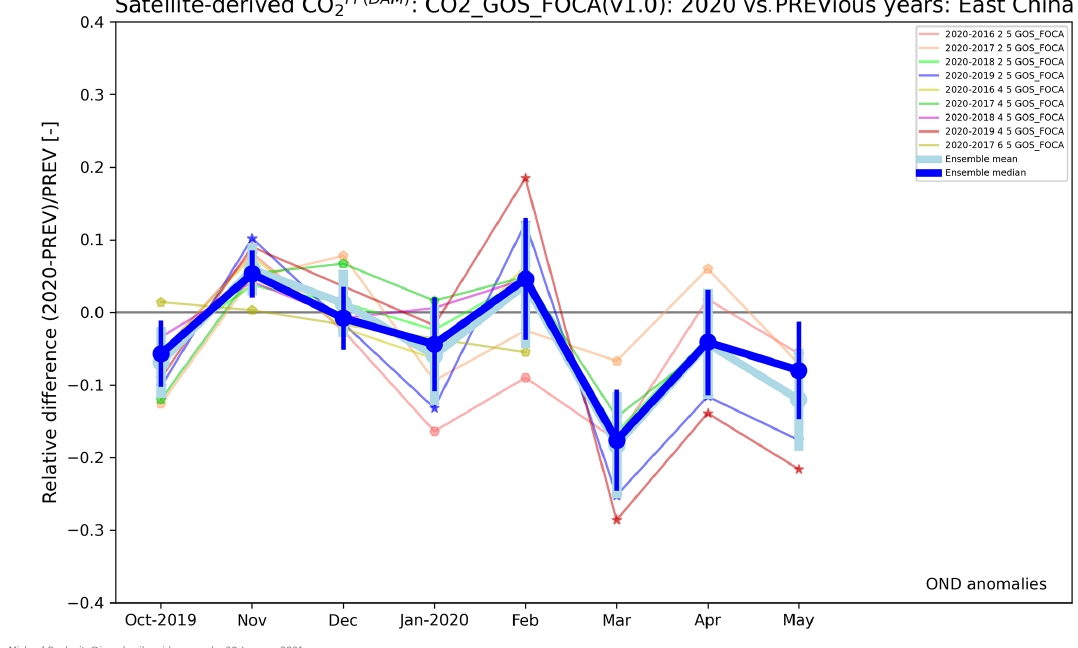
Figure 12. The same as Fig. 10 but for the product CO2_GOS_FOCA.